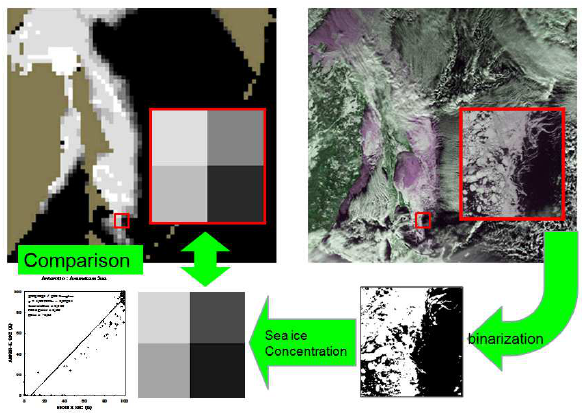
Figure 3. Procedure of validating AMSR2 sea ice concentration using MODIS data